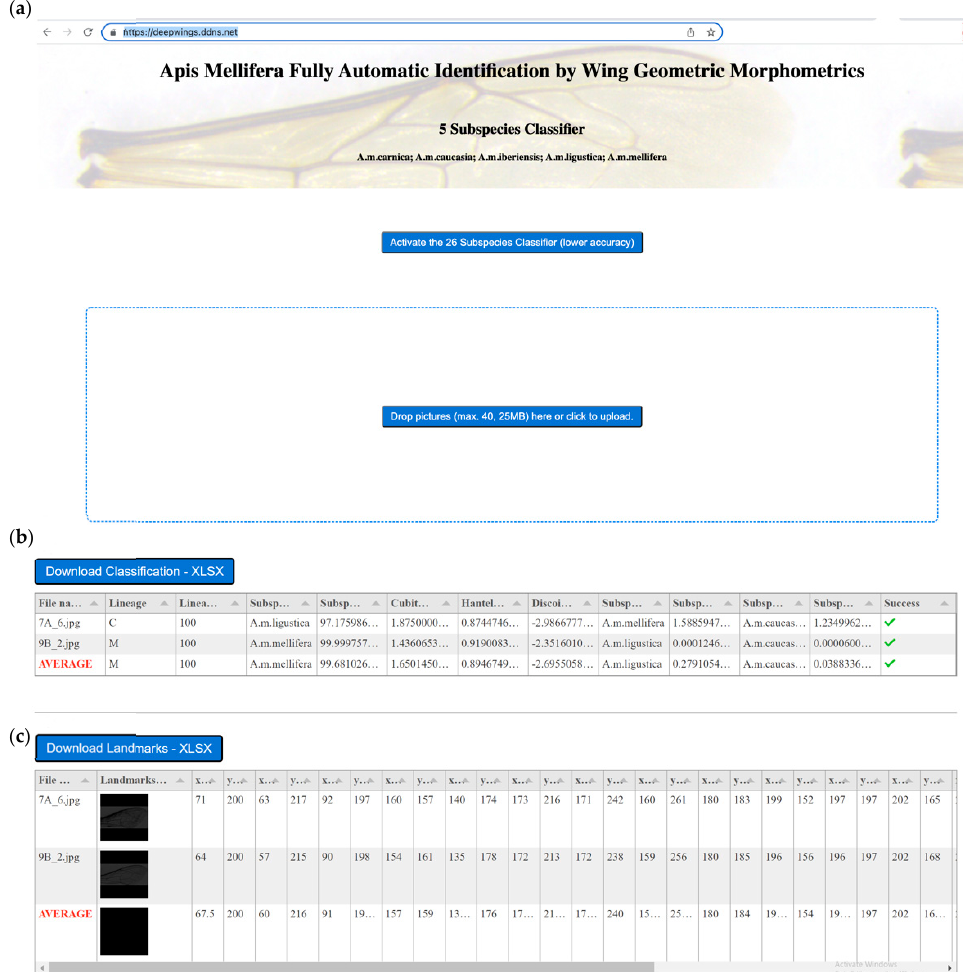
Figure 13. Deep Wings© running as a Web service. ( a ) Interface showing the drop file zone where wing images are uploaded. Interface showing the output tables containing the ( b ) subspecies classification and ( c ) landmark coordinates.